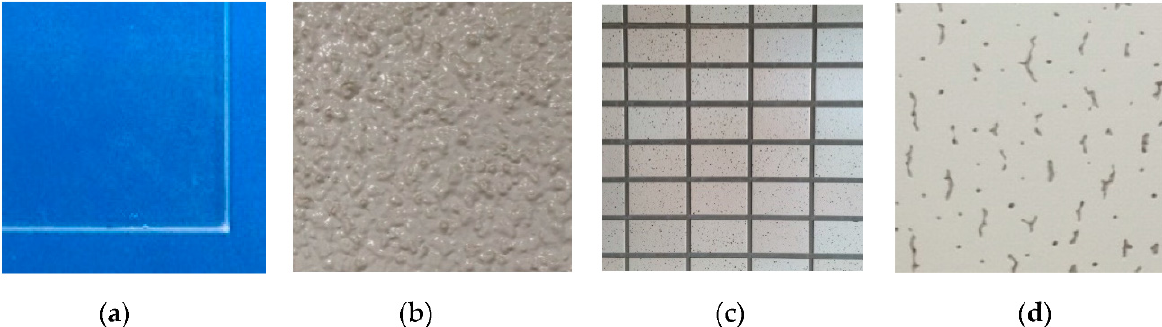
Figure 6. Four different planes used in the experiment: ( a ) acrylic board, ( b ) mortar wall, ( c ) tile surface, and ( d ) plasterboard, to examine the suctioned mode.